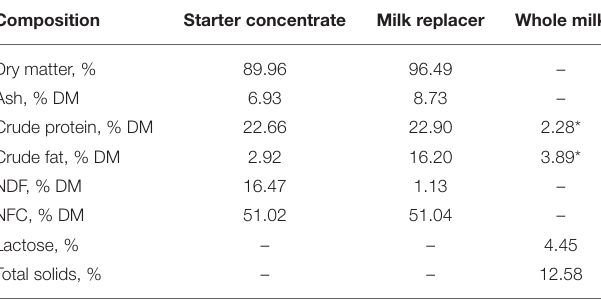
TABLE 1 | Chemical composition of the starter, milk replacer and whole milk.